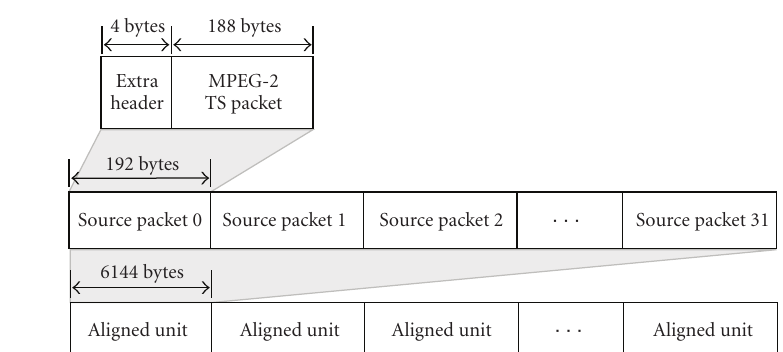
Figure 6: BDAV transport stream.